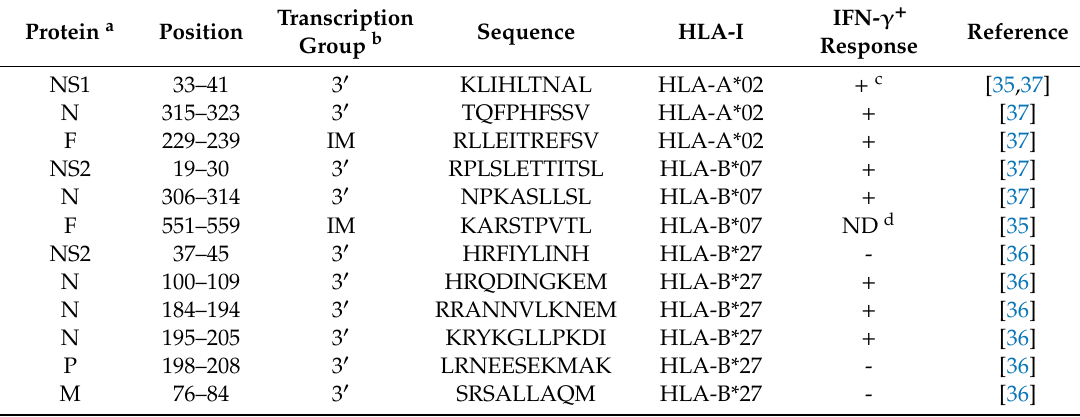
Table 2. Summary of the viral HLA class I natural ligands identified by immunoproteomics analyses in HRSV-infected cells.